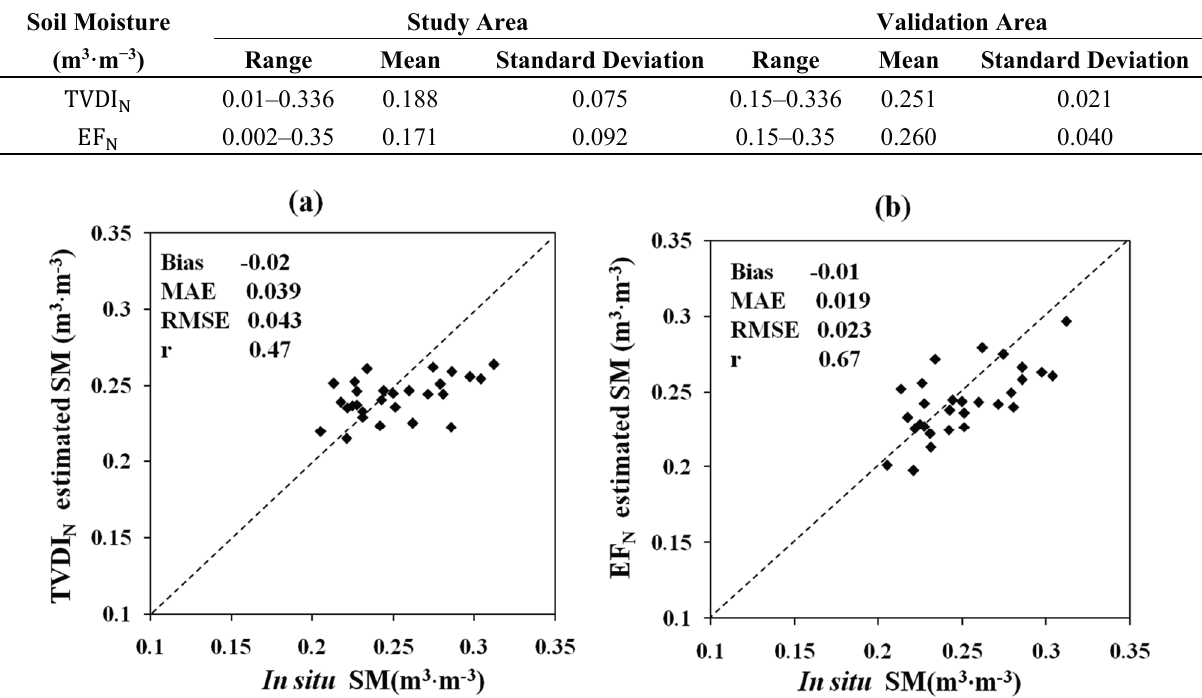
and EF . (cid:2898) (cid:2898)